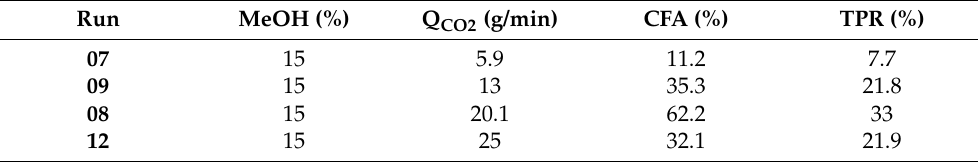
Table 6. Run 12 (very high CO 2 flow rate) compared to runs with lower solvent flow rates. Run MeOH (%) Q CO2 (g/min) CFA